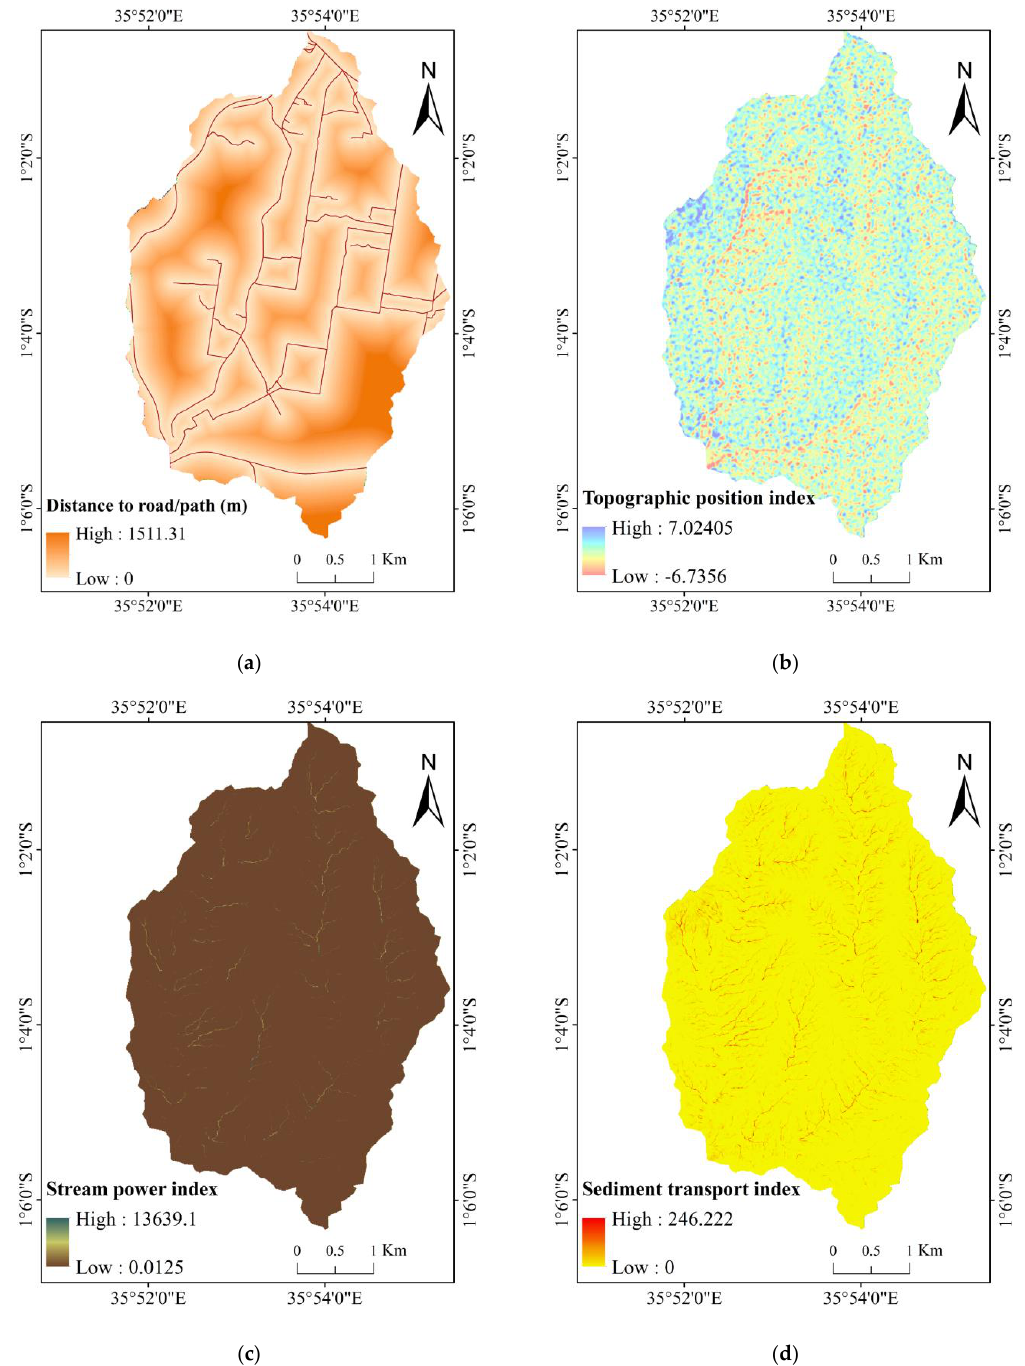
Figure 5. Gully erosion conditioning factors: ( a ) distance to road, ( b ) topographic position index (TPI), ( c ) stream power index (SPI) and ( d ) sediment transport index (STI). Topographic position index (TPI) is a widely used approach for evaluating topographic slope location. It is the difference between the elevation of a cell and the average of the surrounding cells [17]. It was calculated for each cell using the algorithm [46] denoted by Equation (2) in QGIS using SAGA-GIS. The TPI values for the study area range between − 6.7 and 7 and were divided into five classes (Figure